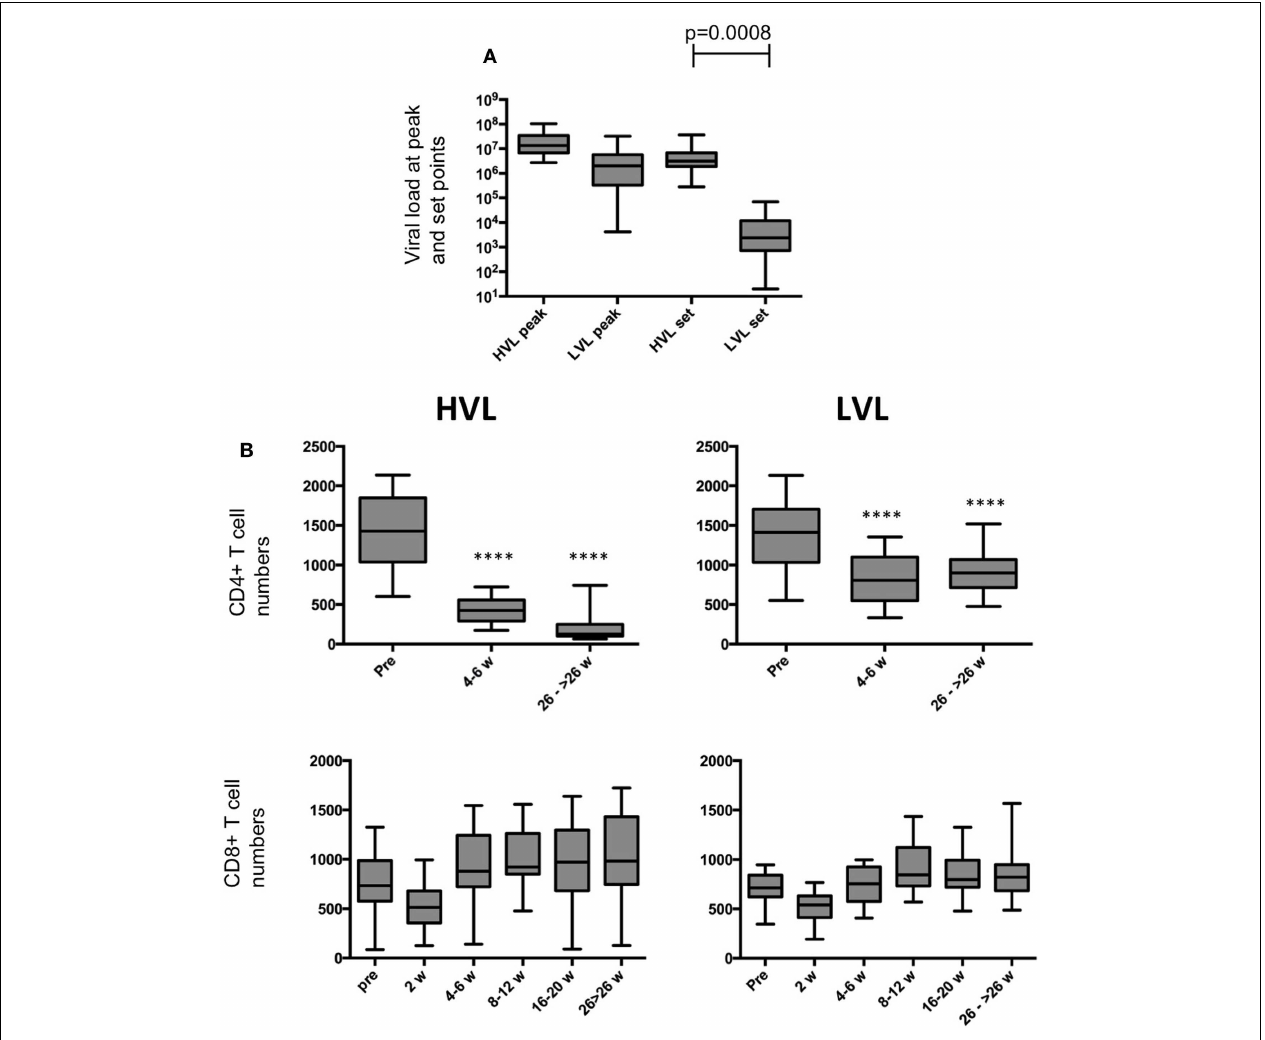
T cell and CD8 + T cell numbers during course of SIV infection in peripheral blood of HVL and LVL animals.T-tests were performed between the cell numbers of corresponding time points and were indicated as **** p <